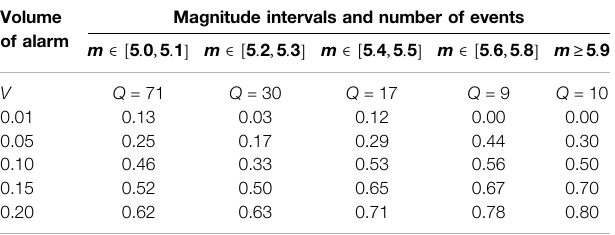
TABLE 6 | The Aegean Region: probabilities of earthquake forecasts for the magnitude intervals m ∈ [ 5 . 0 , 5 . 1 ] , m ∈ [ 5 . 2 , 5 . 3 ] , m ∈ [ 5 . 4 , 5 . 5 ] , m ∈ [ 5 . 5 , 5 . 8 ] , m ≥ 5 .